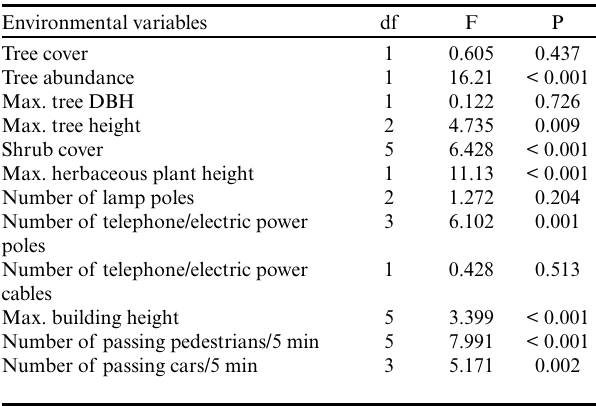
Table 5 . Generalized additive mixed model for House Sparrow ( Passer domesticus ) abundances in the three studied urban- agricultural landscapes, considering “city” as a random